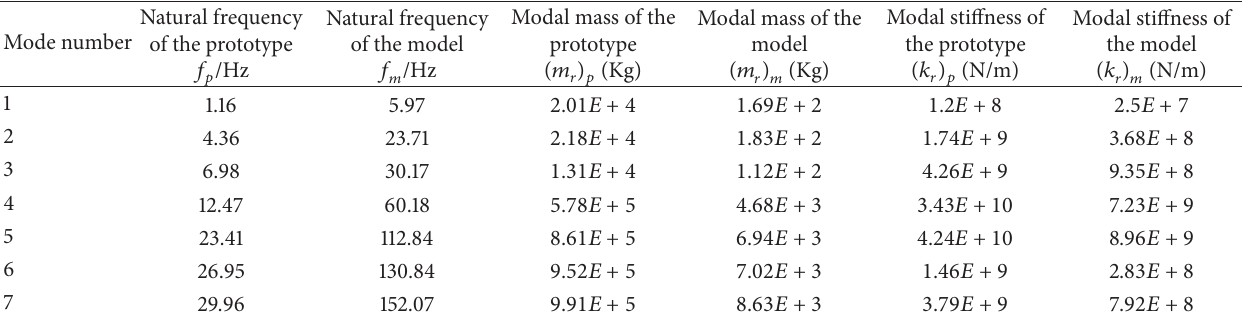
Figure 3: The sixth mode shape of the prototype compared to the model screen. (a) The bending mode shape of the prototype. (b) The bending mode shape of the model. Table 2: The similar relations of the natural frequency, modal mass, and modal stiffness.